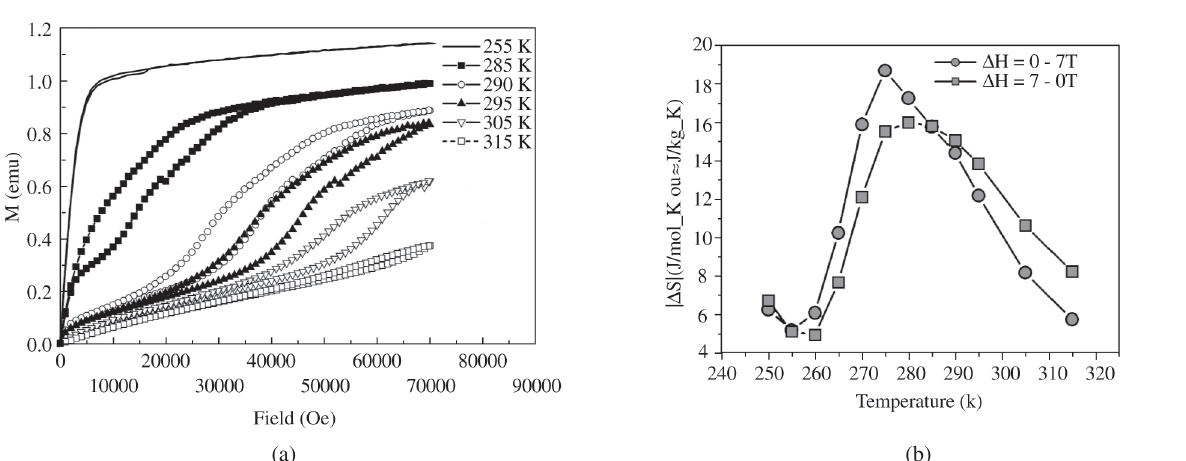
Figure 5. M vs. H curves a) and the calculated MCE b) for the heat-treated alloy, produced from commercial Gd (99.9%